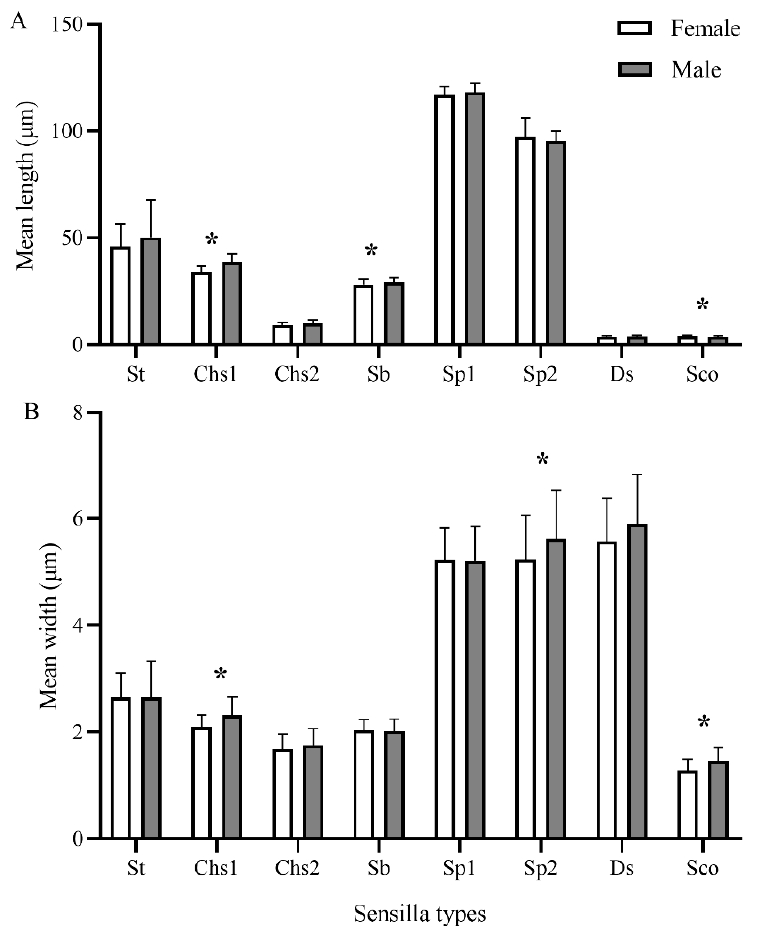
Figure 13. Length and width of different types of antennal sensilla in both sexes of C. qinlingensis . Data are the mean ± SD of at least 40 individual sensilla of five wasps of each sex. Asterisks (*) indicate significant differences between the two sexes ( p < 0.05). Table 4. Features of the sensilla placodea of the antennae of female and male C. qinlingensis (N=5).